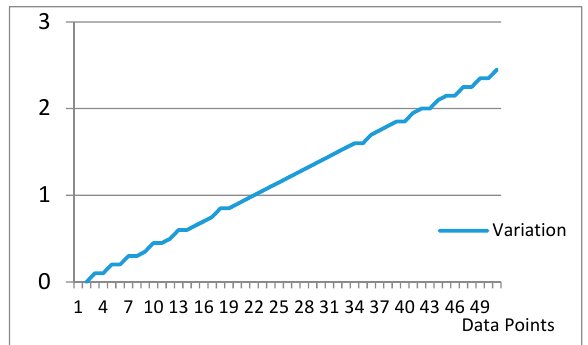
Figure 13. Model of the variation generated by numerical methods.